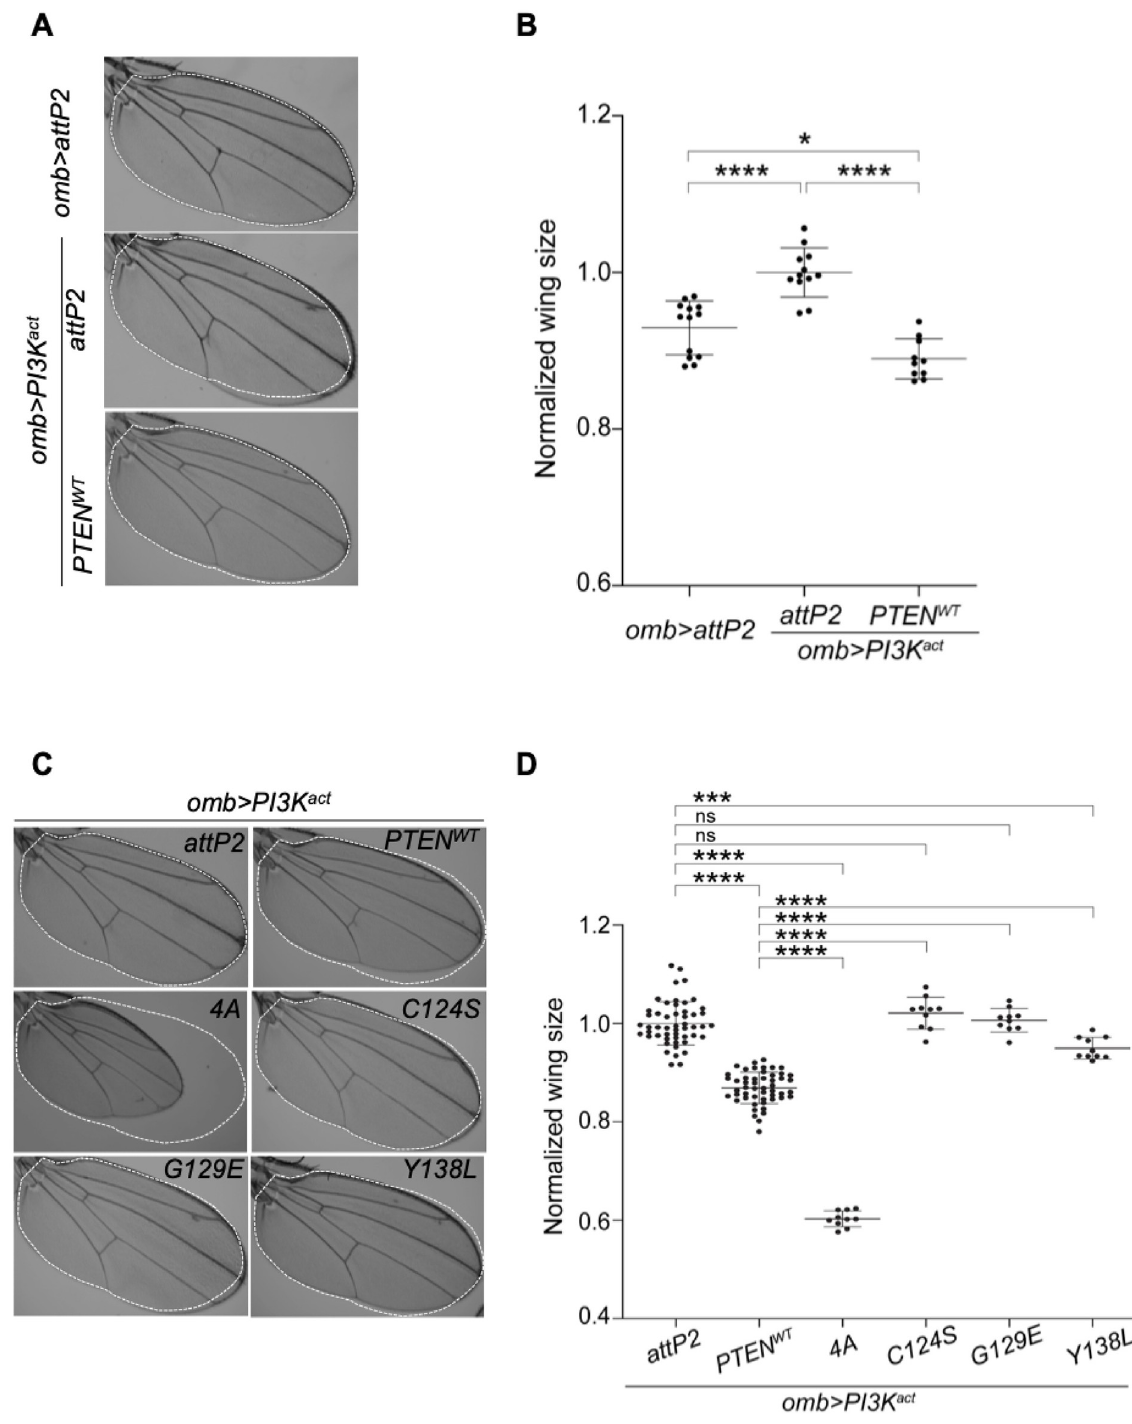
Fig 2. Human PTEN suppresses PI3K-induced wing growth in Drosophila . UAS-PI3K act and UAS-PTEN variants were crossed to the wing pouch-specific GAL4 driver ( omb-GAL4) to test wing growth. ( A ) Representative image of adult wing of omb-GAL4 crossed to attP2 parental strain. ( A, C ) Representative images of adult wings of flies expressing UAS-PI3K act ( omb > PI3K act ) plus a UAS-PTEN variant or attP2 . ( B, D ) Graphs showing normalized wing size for each genotype shown. Expressing PTEN-WT suppressed PI3K act induced wing overgrowth. Expression of 4A reduced wing size. C124S and G129E acted as loss of function variants, and Y138L functioned as a partial loss of function. Each datum point within scatter plots represents a single adult wing. Data are expressed as mean ± SD and analyzed using one-way ANOVA with Tukey HSD post-hoc; � p < 0.05, �� p < 0.01, ��� p < 0.001, ���� p < 0.0001. ns = not significant.